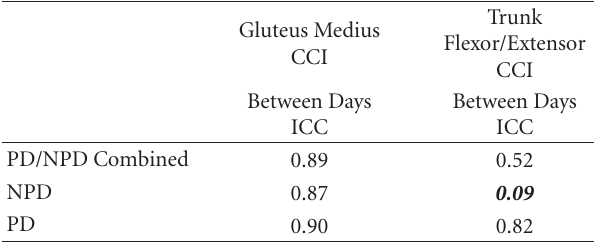
Table 6: Between-day repeatability for trunk flexor/extensor and gluteus medius cocontraction index during standing. Poor repeata- bility is indicated in bold italic .